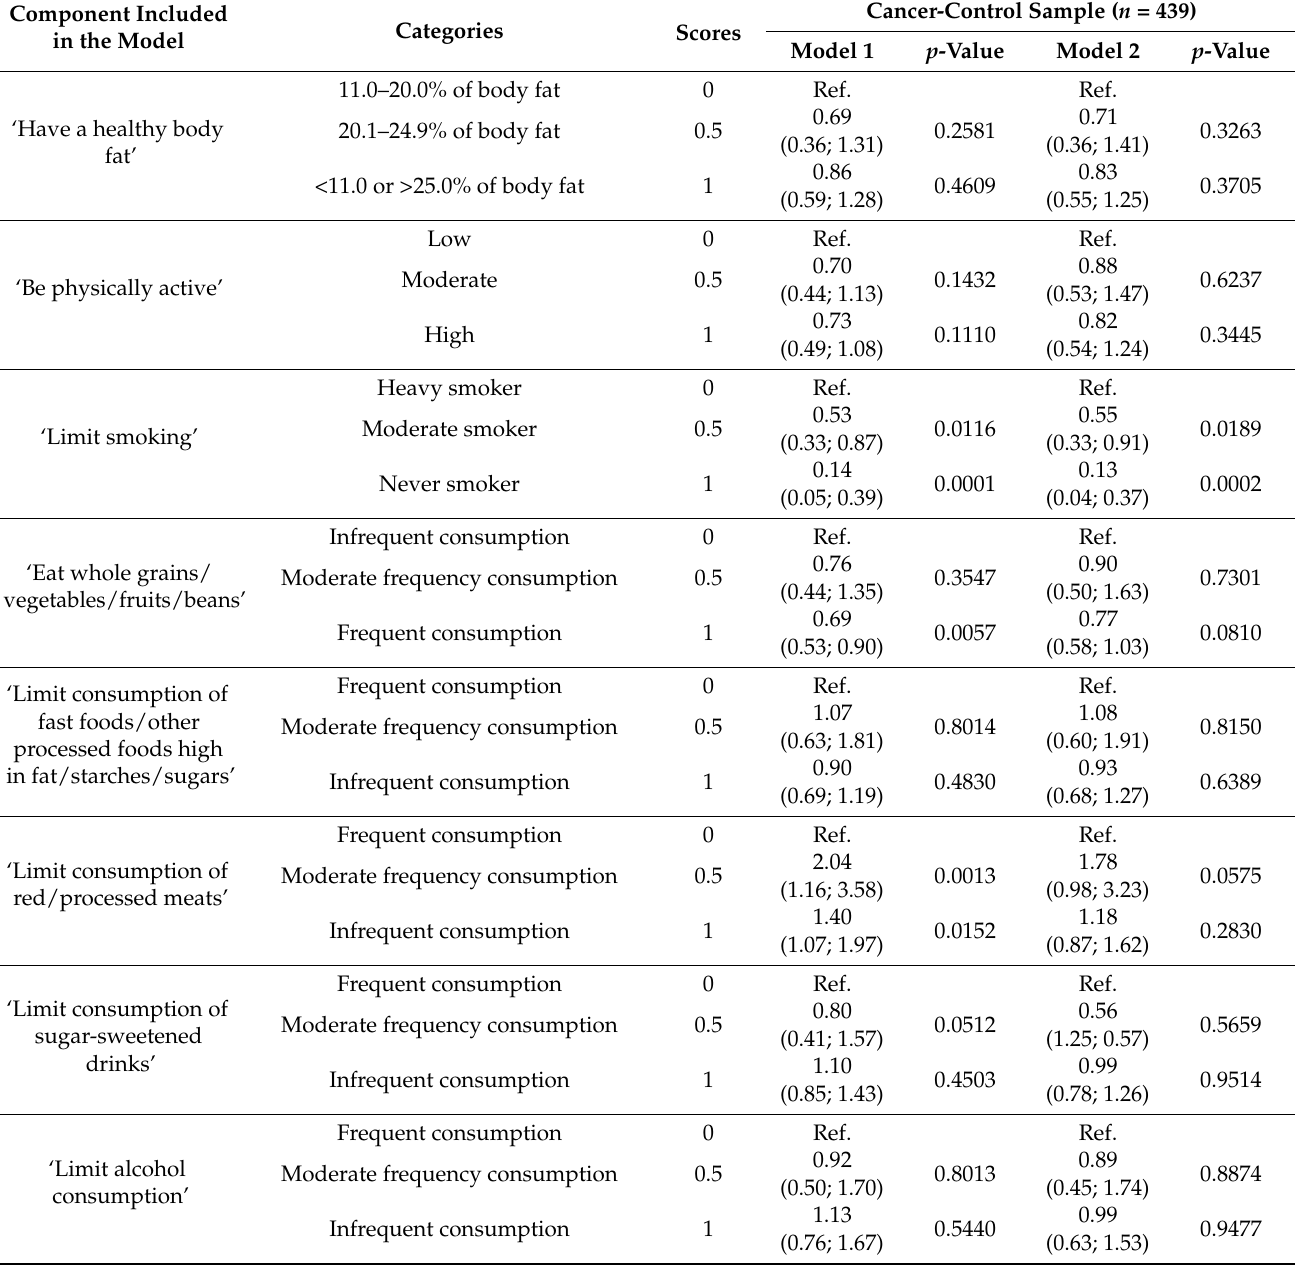
Table 7. Odds ratios (95% confidence intervals) of lung cancer occurrence for single components of Ad-LC WCRF/AICR